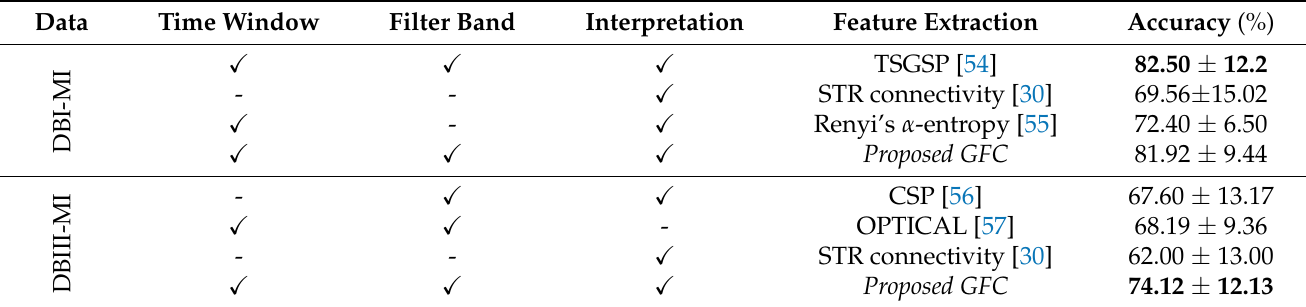
Table 1. Classifier accuracy comparison of approaches using functional connectivity features recently reported against the Gaussian FC performance in discriminating MI tasks. Notation TSGSP is temporally constrained sparse group spatial pattern, STR is space-time recurrence, and OPTICAL is Optimized CSP with long short term memory (LSTM). The best value performed for each database is marked in